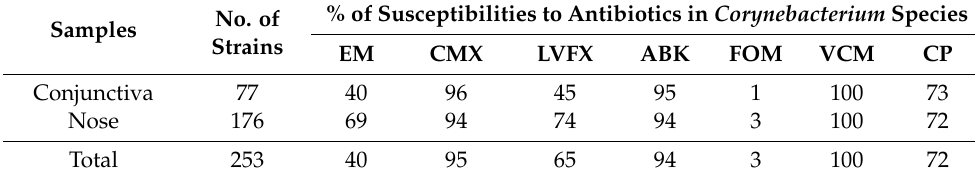
Table 3. Antibiotic susceptibilities of Corynebacterium species from the conjunctiva and nose. No. Samples